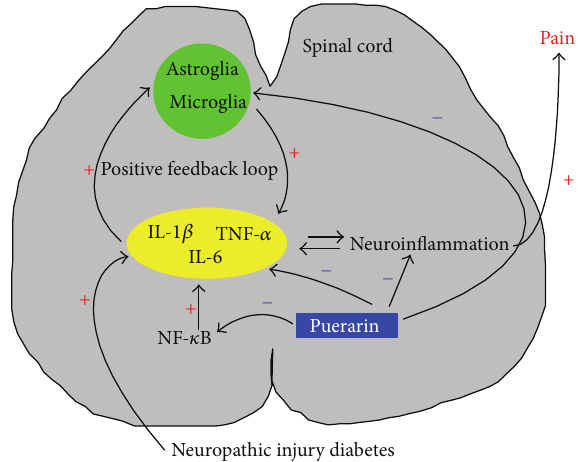
Figure 6: Hypothetical mechanisms of antineuroinflammation activity of